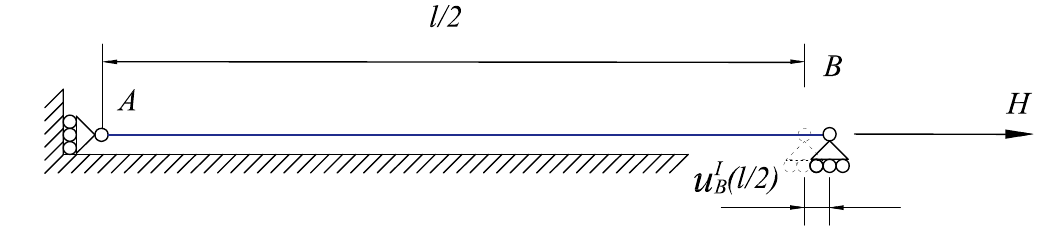
Figure 3. Phase I: Stressing. Horizontal static state. Application of the horizontal external force H . The initial profile of the cable was a horizontal